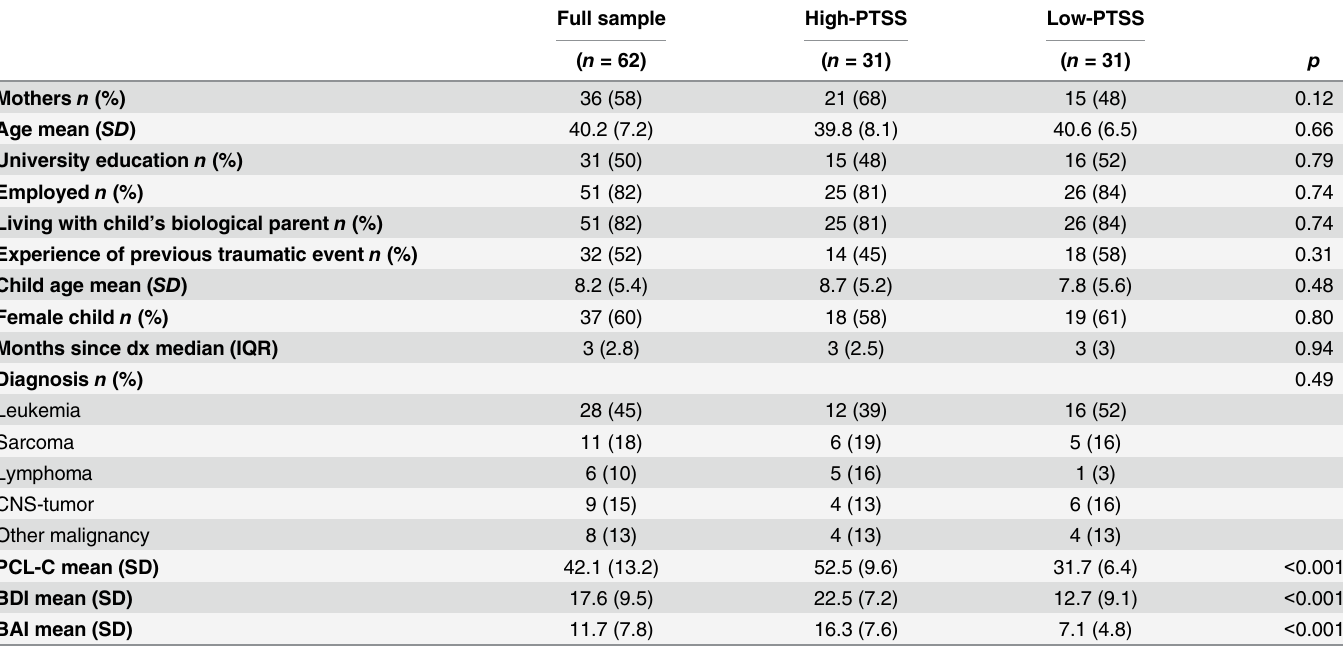
Table 1. Demographic and Clinical Characteristics for the Participants and their